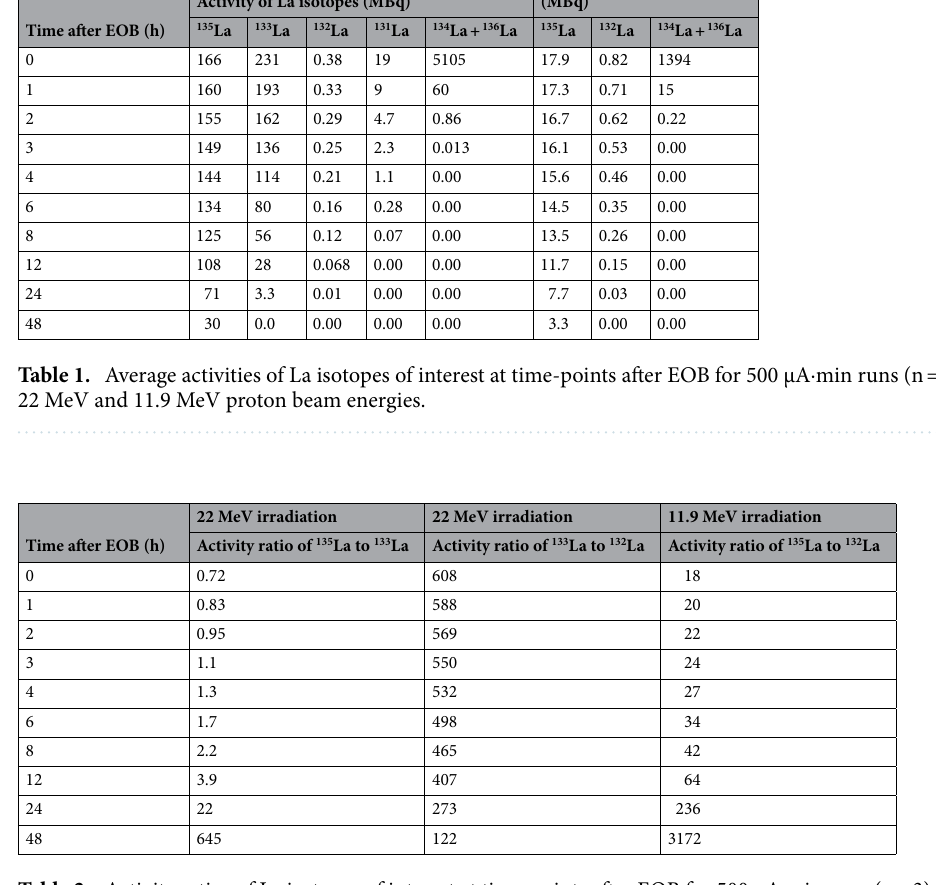
Time after EOB (h)